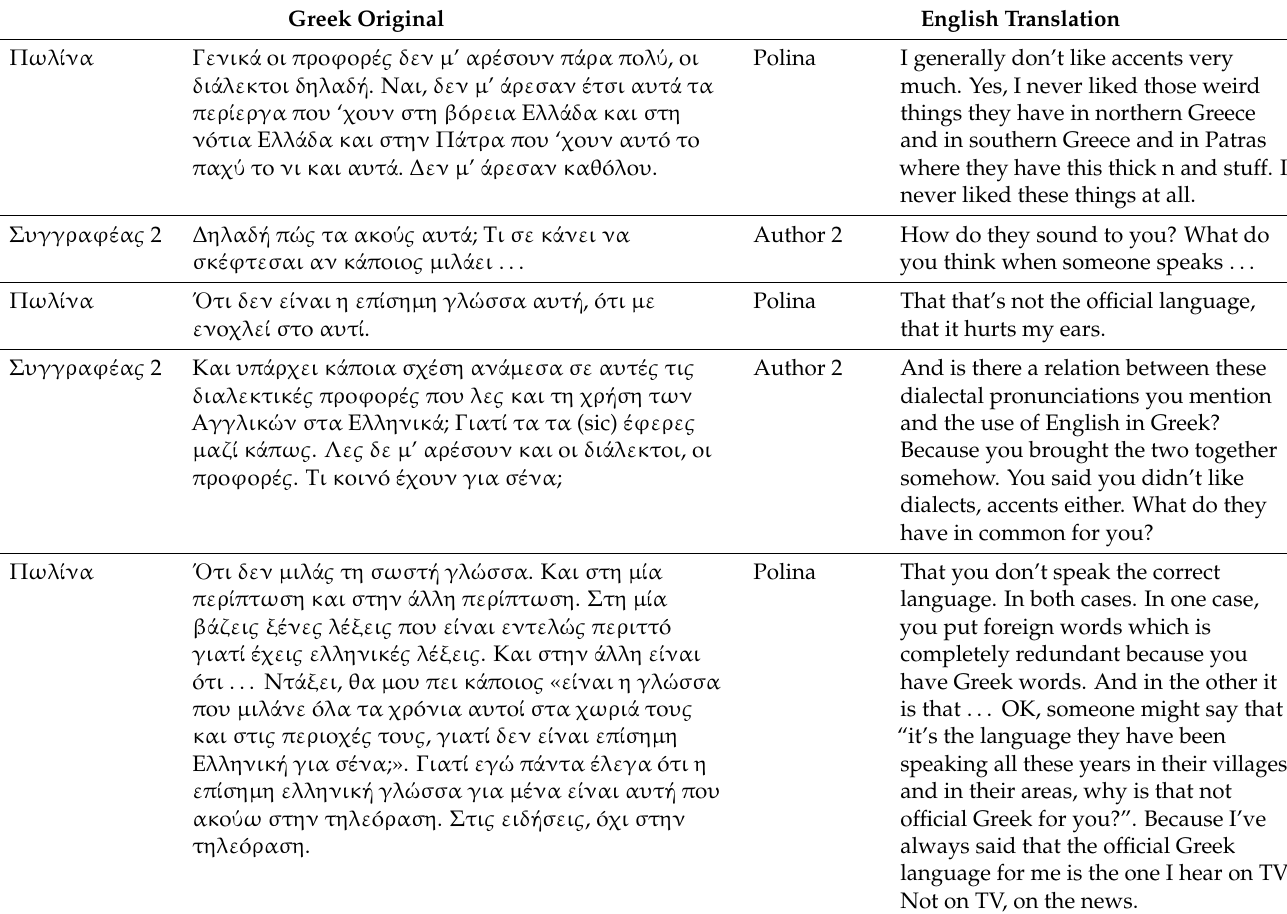
Table 7. “You don’t speak the correct language”.